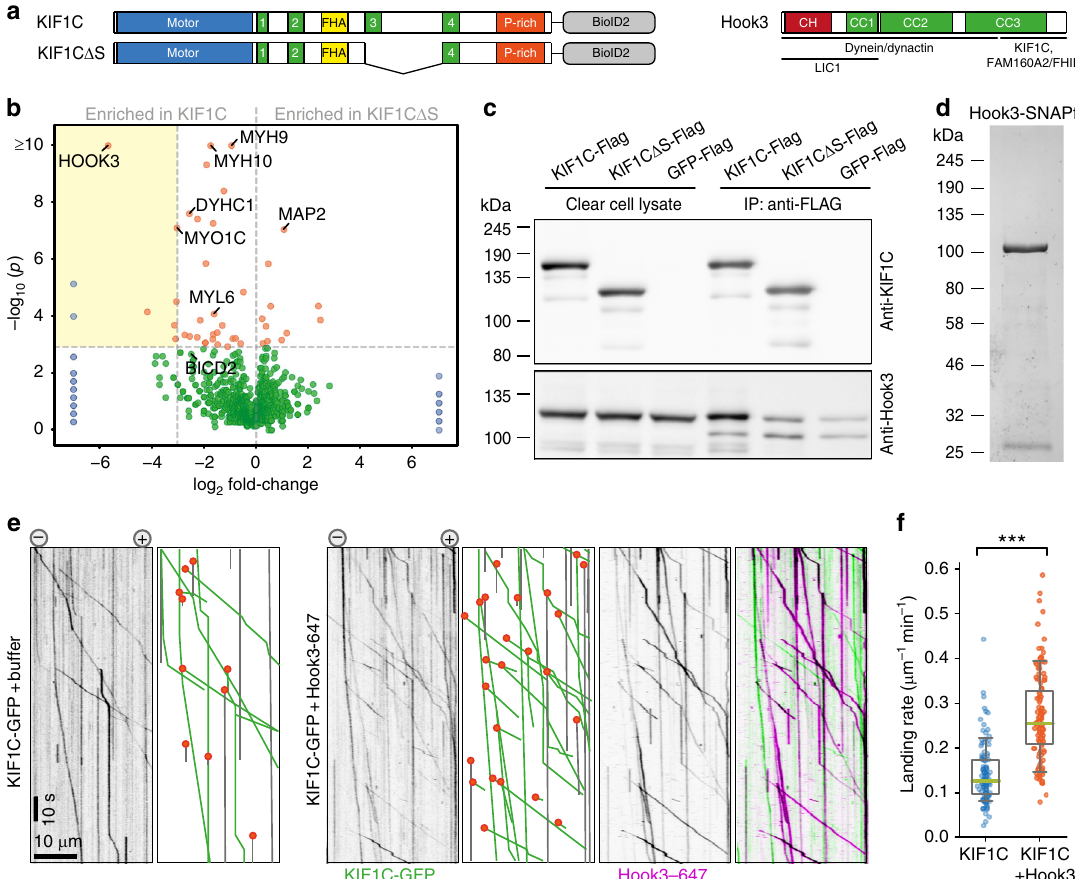
Fig. 7 Hook3 activates KIF1C. a Schematic primary structure of constructs used for BioID: full-length KIF1C and KIF1C Δ S. Hook3 is also shown together with regions of con fi rmed interactors. b Volcano plot shows ratio of proteins enriched in KIF1C Δ S relative to full-length KIF1C relative to p -value of Fisher ’ s exact test. Proteins in blue were only present in one of the samples. Proteins labelled in orange are signi fi cantly enriched across the repeats. The yellow box includes all signi fi cant hits that are at least 10-fold enriched in full-length KIF1C sample. n = 3 independent experiments, one of which included three replicates. See Supplementary Data 1. c Co-immunoprecipitation of Hook3-GFP with KIF1C-Flag, KIF1C Δ S-Flag and GFP-Flag from HEK cell lysates. Uncropped gels are provided in Source Data fi le. d Coomassie-stained SDS-PAGE of puri fi ed Hook3-SNAPf. The contamination at ~27 kDa is TEV protease used to cleave the protein off the puri fi cation tag. e Representative kymographs from single-molecule experiments of KIF1C-GFP alone or in the presence of Hook3 labelled with Alexa647. Motility and landing events indicated as in c . f Quanti fi cation of absolute frequency of KIF1C-GFP motors landing on microtubules, n = 116 and 131 MTs, respectively, pooled from three independent experiments. *** p < 0.0005 ( t -test). Data are provided in Source Data fi